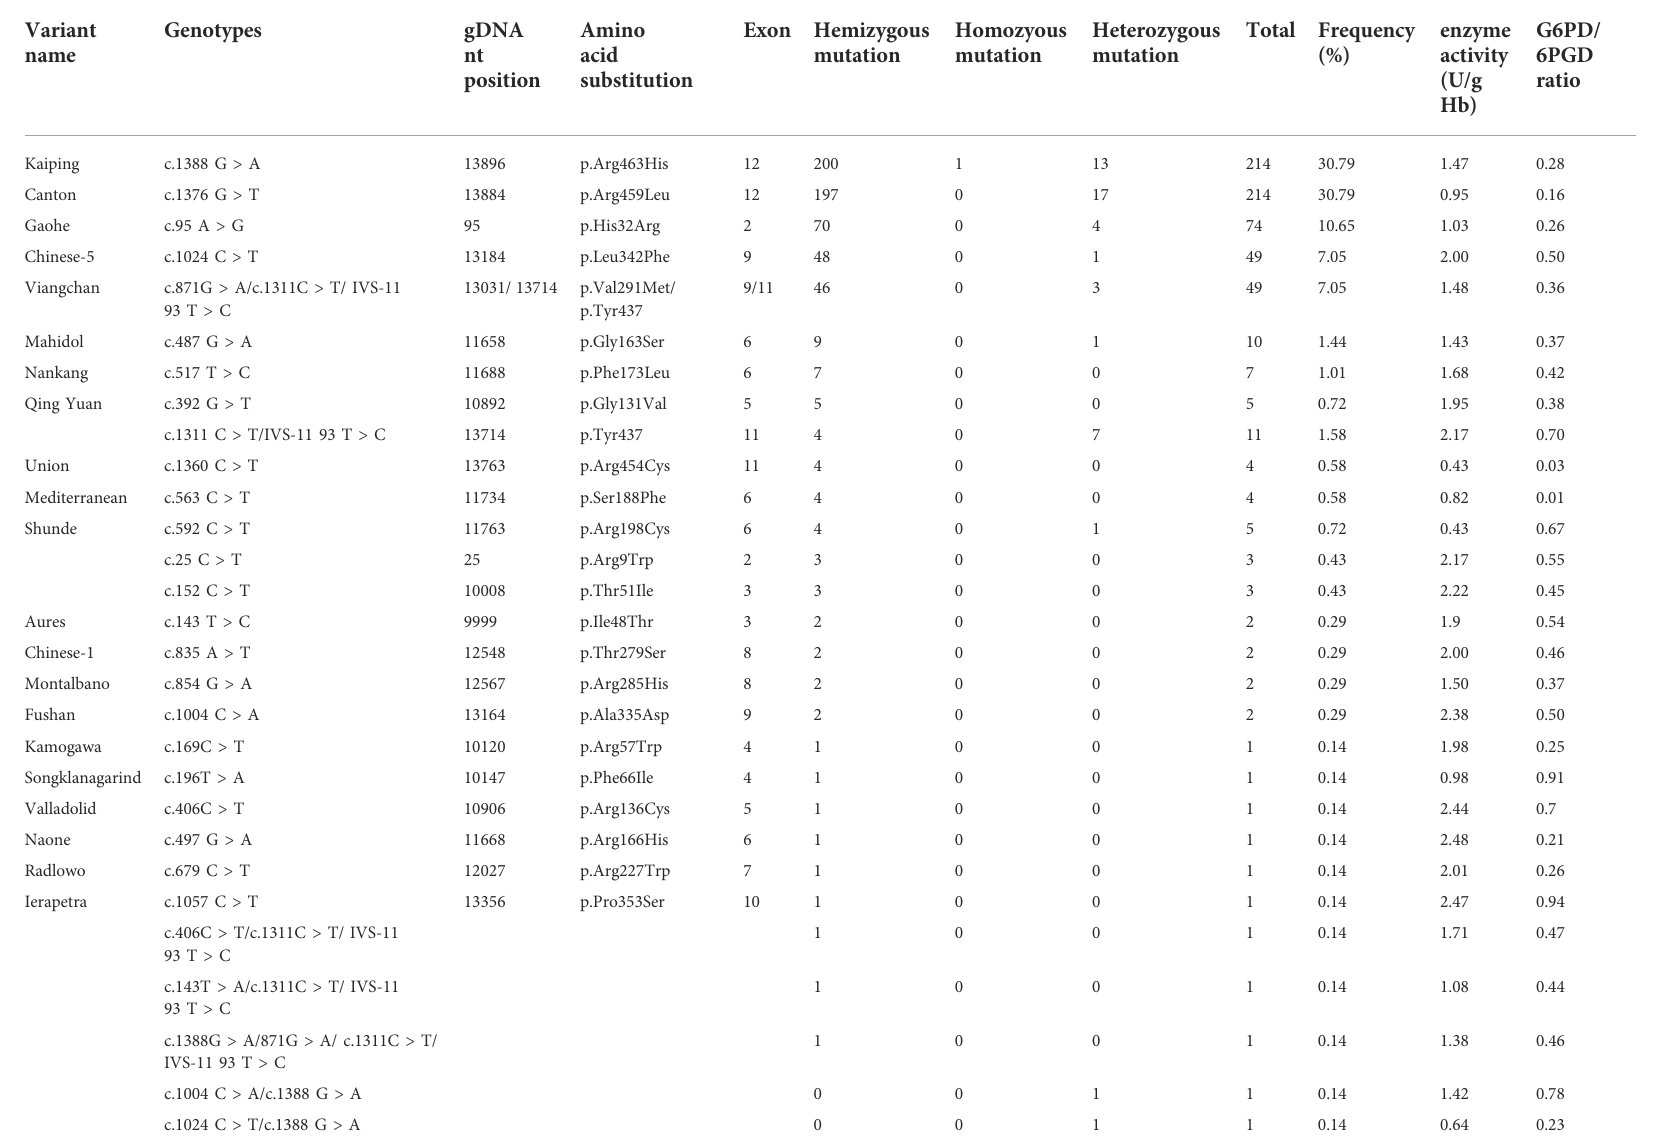
TABLE 2 The number and frequency of different G6PD genotypes in the Wuhan